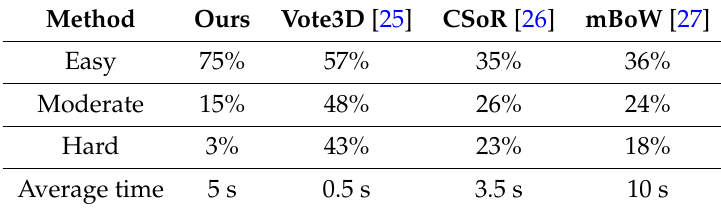
Table 1. Performance of the vehicle detection approach compared with the